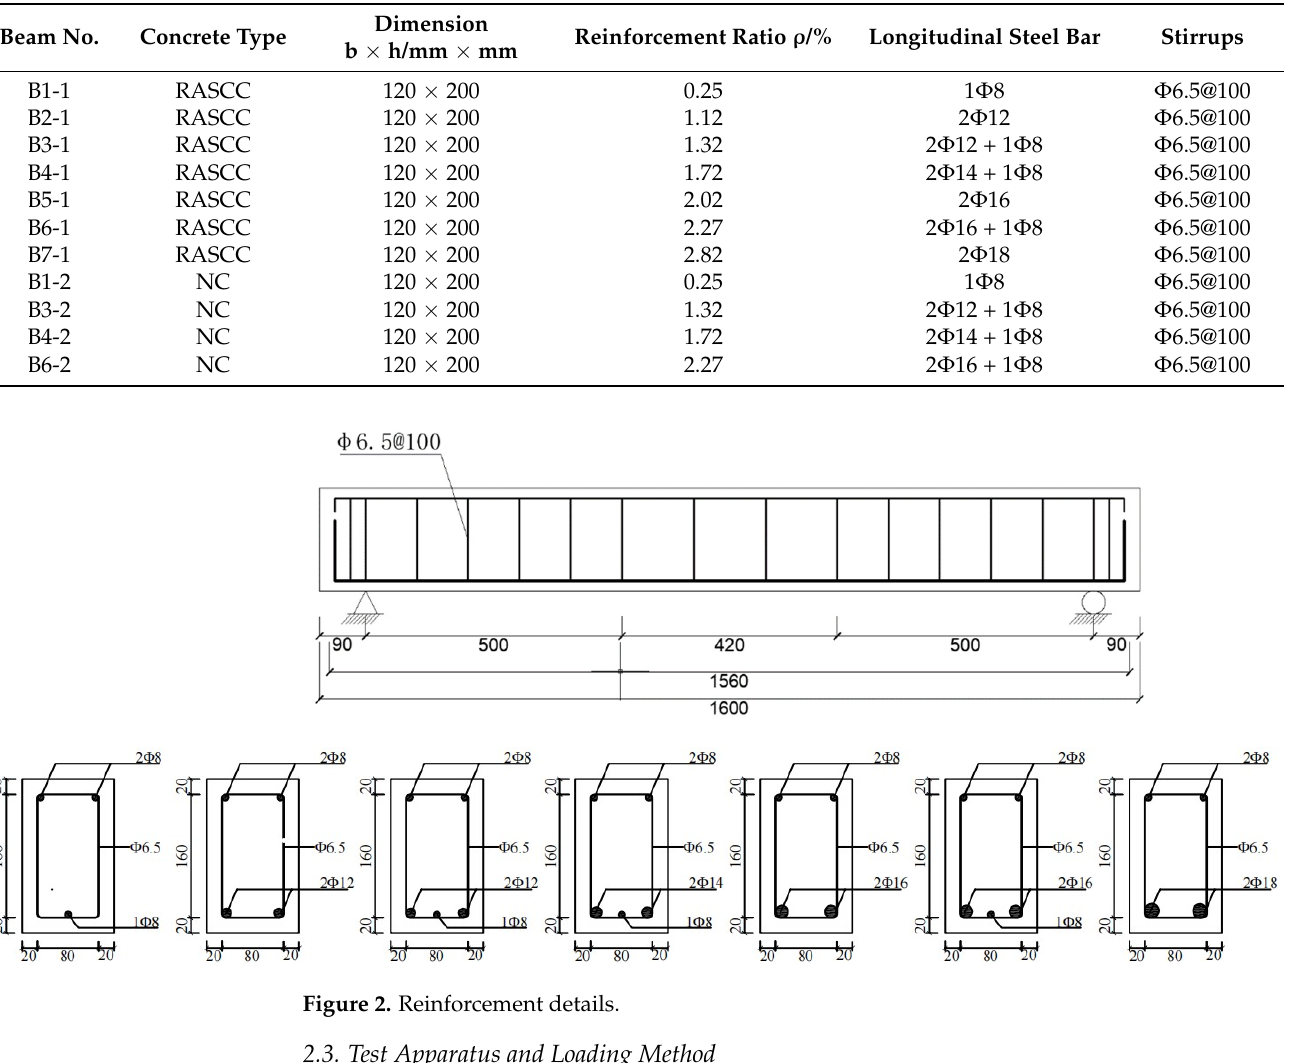
Table 4. The design parameters and reinforcement of the test beams.